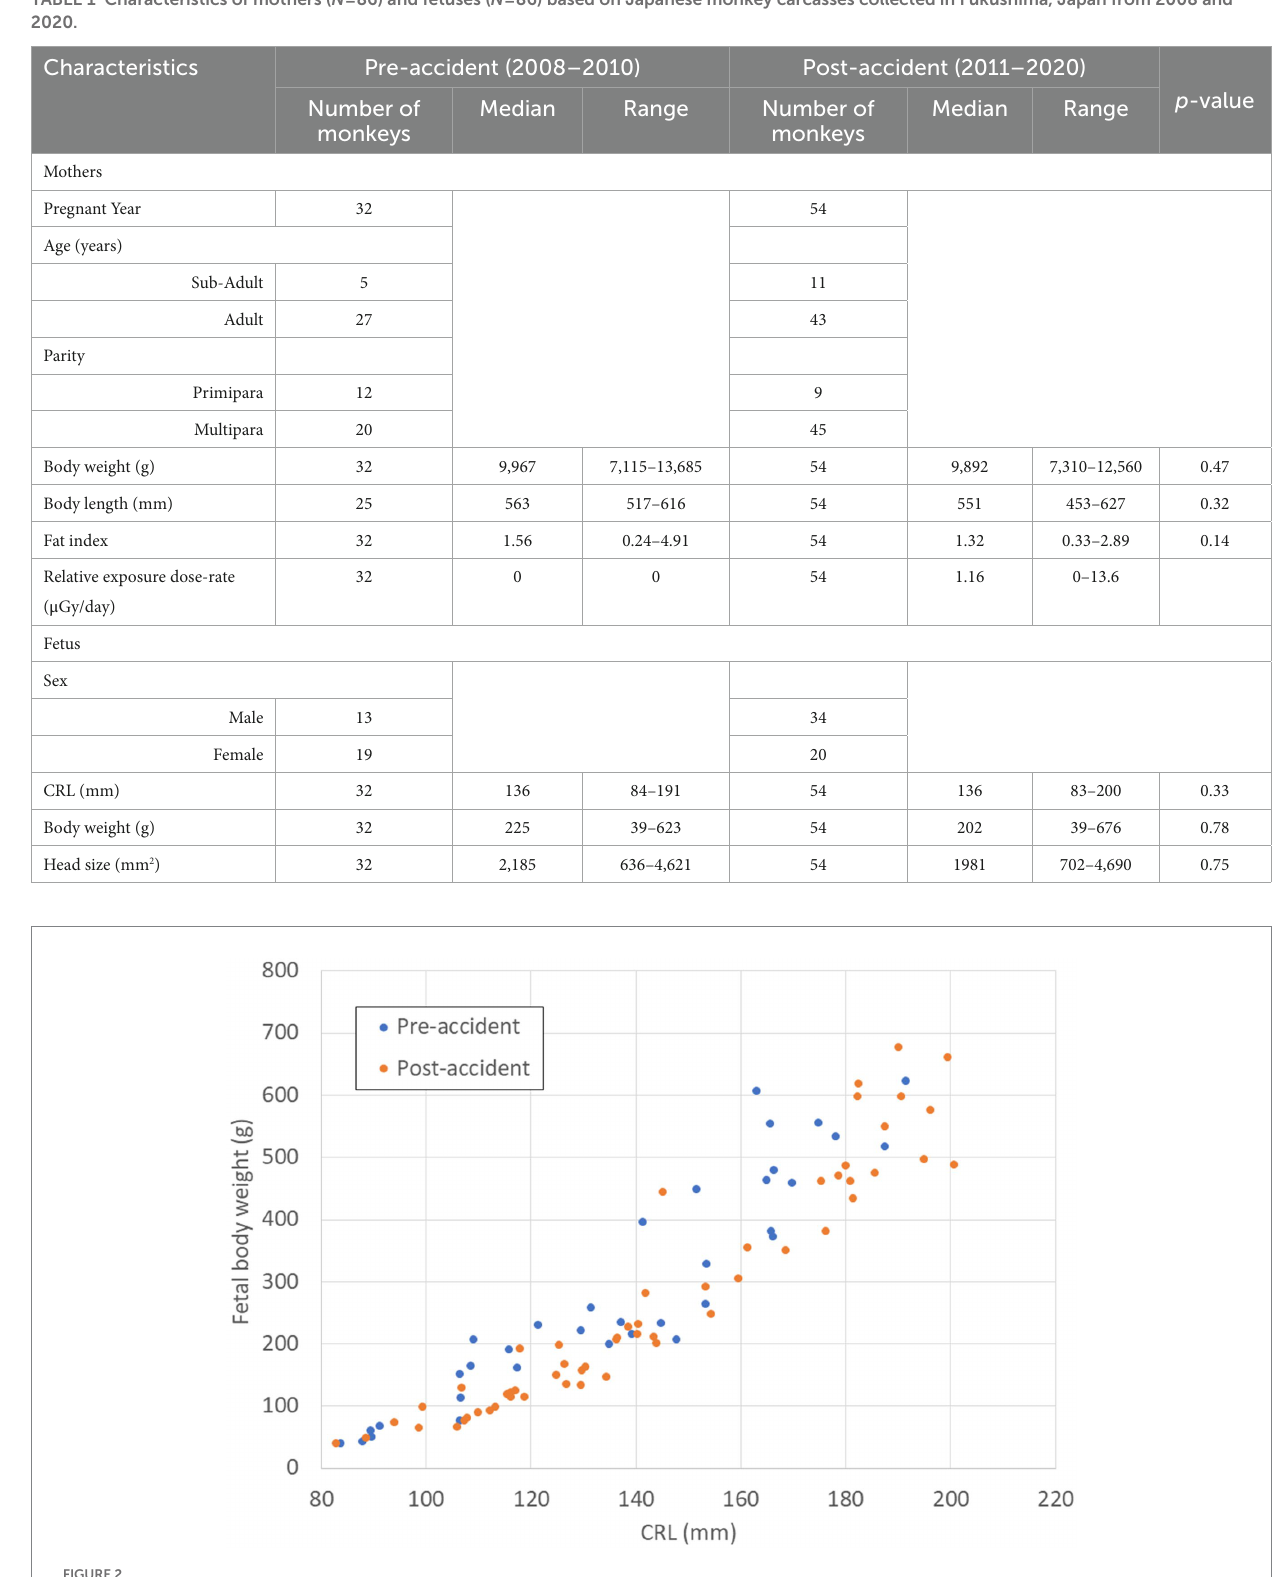
FIGURE 2 Relationship between CRL (mm) and FBW (g) in fetal Japanese monkeys before and after the Fukushima Daiichi nuclear power plant accident. Blue circles indicate fetal monkeys before the accident; red circles indicate fetal monkeys after the accident. CRL, crown–rump length; FBW, fetal body